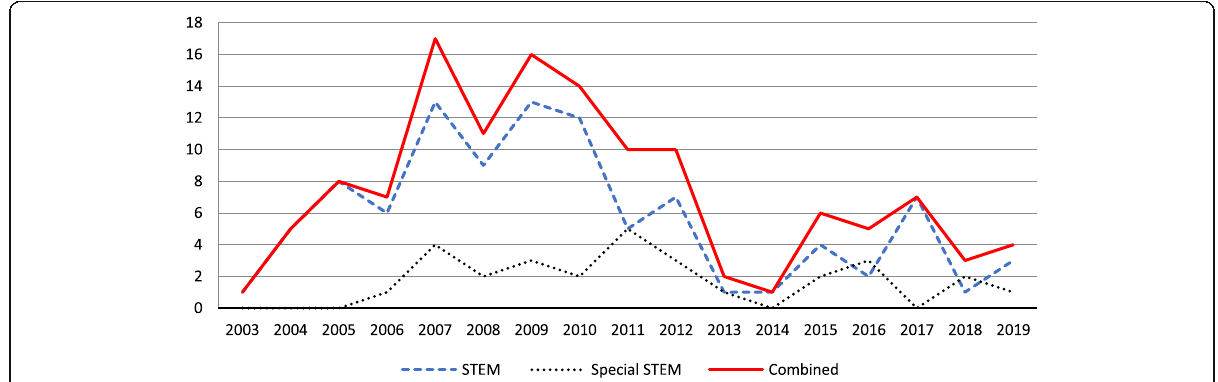
Fig. 2 The distribution of STEM education projects over the years. (Note: STEM refers to projects funded under “ Education Research, ” Special STEM refers to projects funded under “ Special Education Research, ” and “ Combined ” refers to projects funded under both “ Education Research ” and “ Special Education Research. ” The same annotations are used in the rest of the